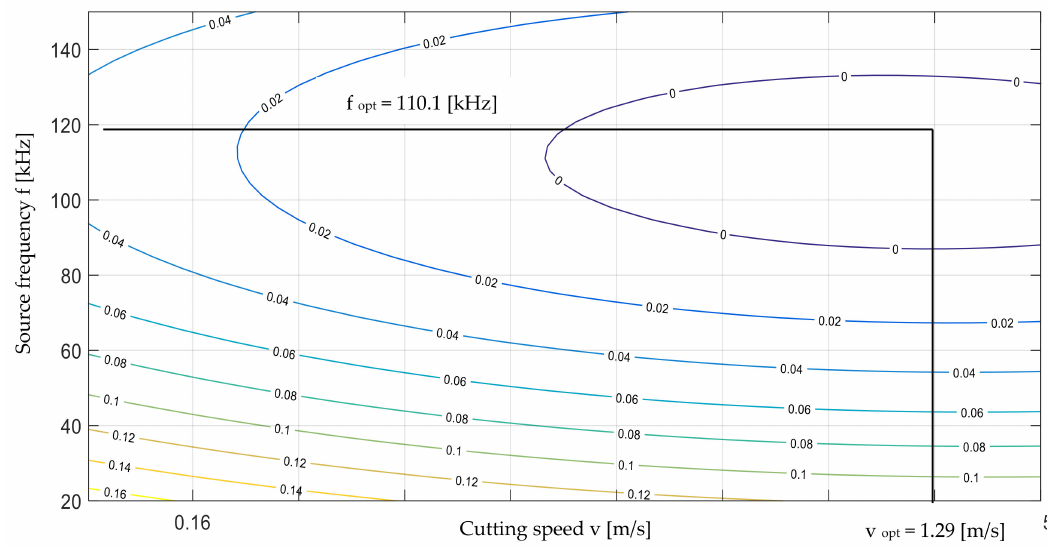
Figure 11. Dependence graph for polypropylene foil thickness t = 50 µ m together with optimal solution marked (solution obtained by two methods).